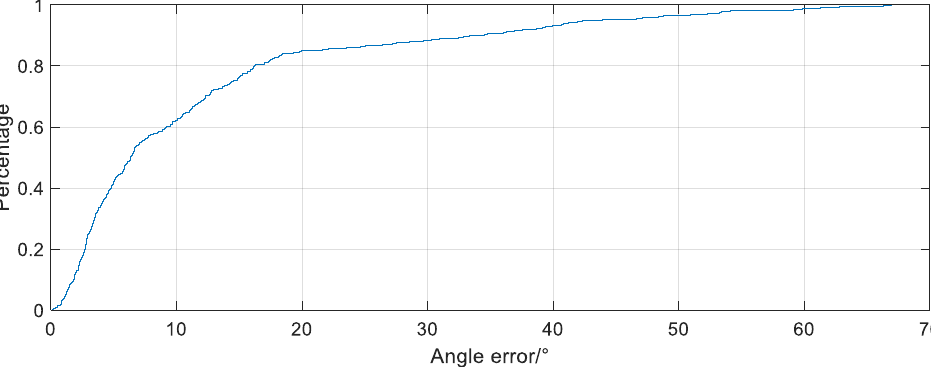
Figure 15. Normalized cumulative distribution of angle errors.